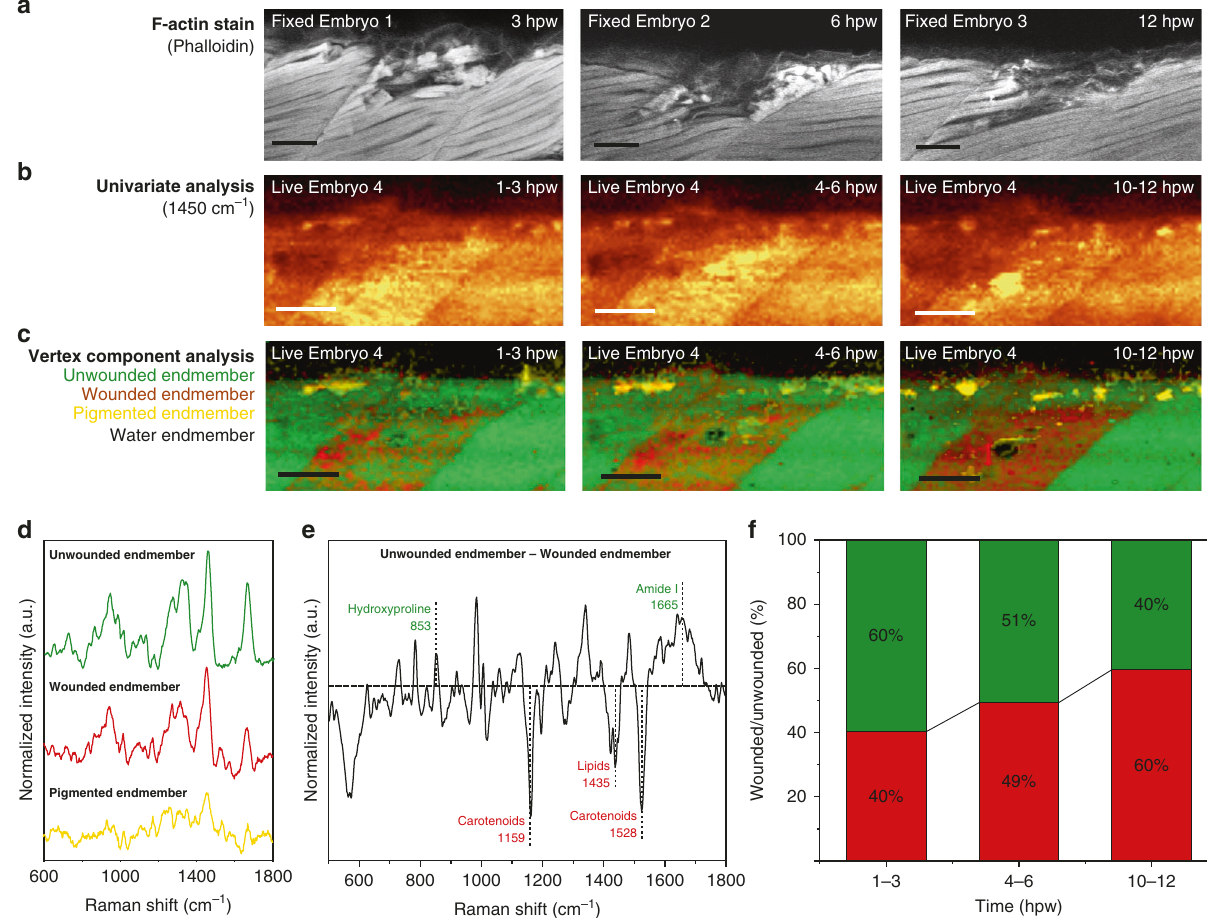
Fig. 6 cRSI of living zebra fi sh embryo wound response. Living zebra fi sh were imaged for the 12 h following a controlled stab wound performed at 3 days post fertilization. a Confocal fl uorescence microscopy of F-actin was highlighted by phalloidin staining (red) at 3, 6 and 12 hours post wounding (hpw) on three independent biological replicates at each time point ( N = 3). b Univariate analysis of the confocal Raman spectroscopic imaging (cRSI) scans of a living zebra fi sh embryo at 1 – 3, 4 – 6 and 10 – 12 hpw. Univariate analysis was performed by integrating over a wavenumber range at 1450 ± 30 cm − 1 . c The tissue damage in these images was clearly visualized by using multivariate vertex component analysis (VCA), with the wounded component displayed in red and the unwounded component displayed in green. A water component (black) and a pigment component (yellow) were also identi fi ed. Scale bars: 40 µ m. d The three tissue endmembers identi fi ed by VCA (the water endmember spectra not shown). e Analysis of the unwounded and wounded endmembers identi fi ed by the VCA. The difference spectrum when the wounded endmember was subtracted from the unwounded endmember. The horizontal dashed line indicates zero difference between the two endmembers. The dotted vertical lines indicate the center of the annotated peaks that were clearly different between wounded and unwounded tissue, with the color coding indicating in which component they were dominant. Green indicates higher presence in the unwounded component and red indicates higher presence in the wounded component. f Relative abundance of wounded and unwounded component in the injured somite at the three time points extracted from pixel intensity histograms produced by the VCA. The wounded component is shown in red and the unwounded component is shown in green. Figures 6b – f are a representative set of images and analysis taken from three independent biological replicates ( N =